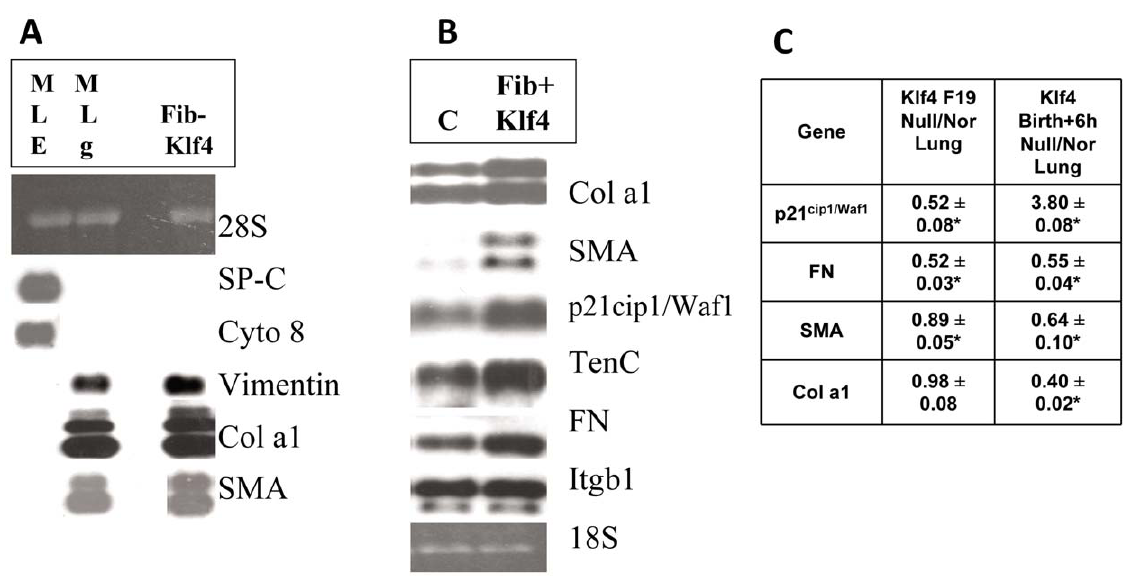
Figure 7. Decrease in connective tissue gene expression in perinatal lung with Klf4 deficiency. ( A ) Cells from the Klf4 null lung were immortalized with SV40Tag as described in Methods. These Klf4 null fibroblasts (Fib-Klf4) express vimentin, the alpha 1 chain of Type 1 collagen (Col a1) and smooth muscle actin (SMA) in common with the mouse lung fibroblasts (MLg), but neither SP-C nor cytokeratin 8 which are found in mouse lung epithelial cells (MLE). The ribosomal marker 28S is shown as a loading control. ( B ) Klf4 cDNA was constitutively expressed in Fib-Klf4 cells to generate Fib + Klf4 cells as described in Methods. Compared to the empty vector control cells (C), these Klf4 expressing fibroblasts (Fib + Klf4) exhibit up-regulated expression of messenger RNA for p21 cip1/Waf1 (2 fold), SMA (3.5 fold), the alpha 1 chain of Type 1 collagen, tenascin C and fibronectin (2– 2.5 fold each) but not fibronectin receptor beta (Itgb1). The ribosomal marker 18S is shown as a loading control. These data represent two independent Northern blot experiments. ( C ) Comparative levels of expression for these Klf4 target genes in Klf4 null lung (null) relative to normal lung (Nor) at fetal day 19 of gestation and 6 h after birth in room air (n=3 for each sample, asterisk denotes difference in level of expression in Klf4 null lung versus normal lung at p ,